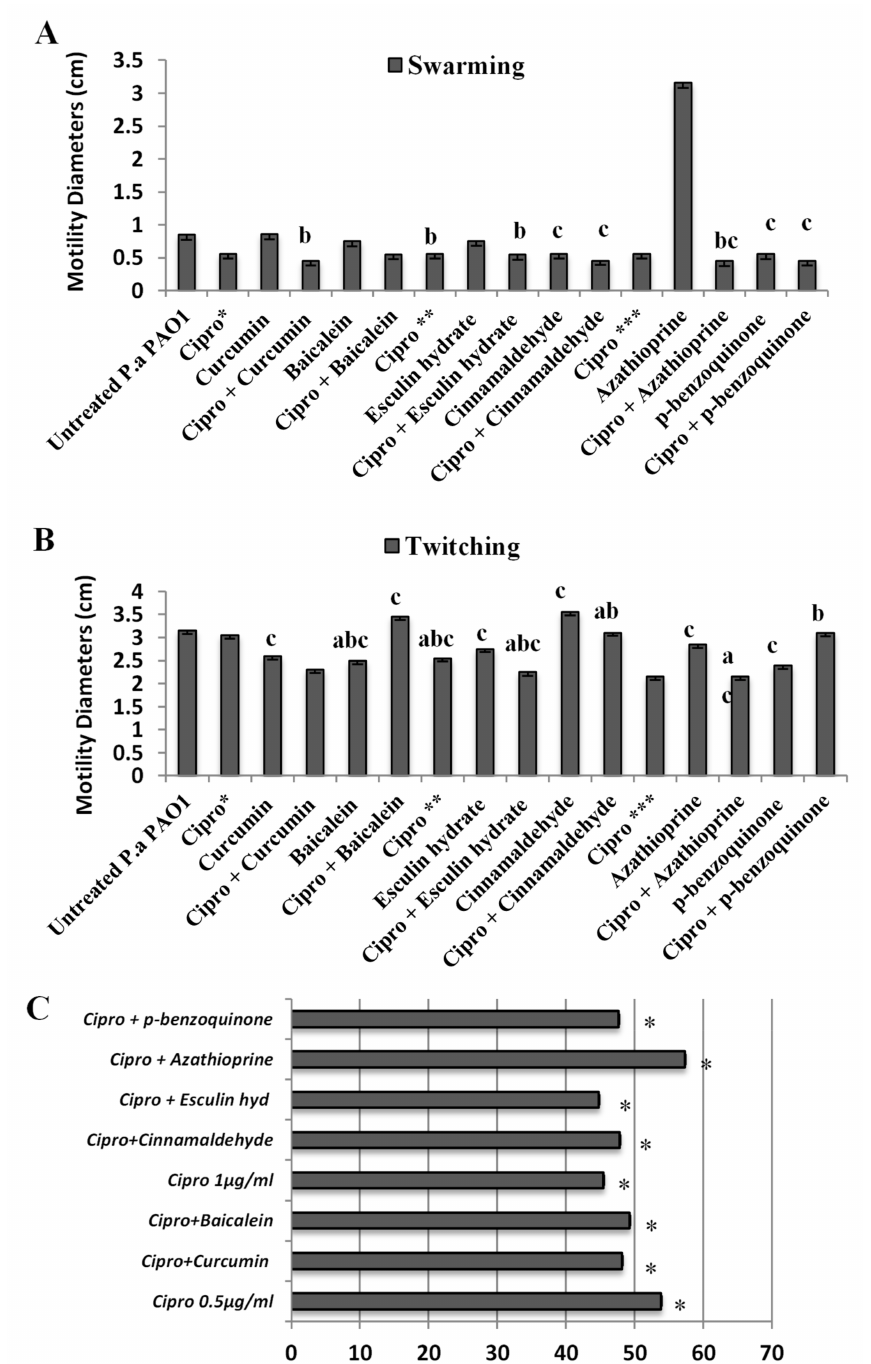
Figure 2. The effect of the antimicrobial agents alone and in combination on the P. aeruginosa biofilm cells: ( A ) twitching motilities and ( B ) swarming motilities. The measurements of the swarming and twitching activity (in centimeter) were performed on the agar plates inoculated with the cells detached from biofilms treated with antimicrobial agents. Cipro*: Ciprofloxacin at 0.0005 mg/L; Cipro**: Ciprofloxacin at 0.001 mg/L; Cipro***: Ciprofloxacin at 0.004 mg/L. (a) It is significantly different than the cells treated with ciprofloxacin ( p < 0.05). (b) It is significantly different than the cells treated with the compounds ( p < 0.05). (c) It is significantly different than the untreated cells ( p < 0.05). ( C ) Quantitation of pyocyanin production in the biofilm cells treated with ciprofloxacin alone and in combination with the compounds. * Significant ( p < 0.05). The results are expressed as %